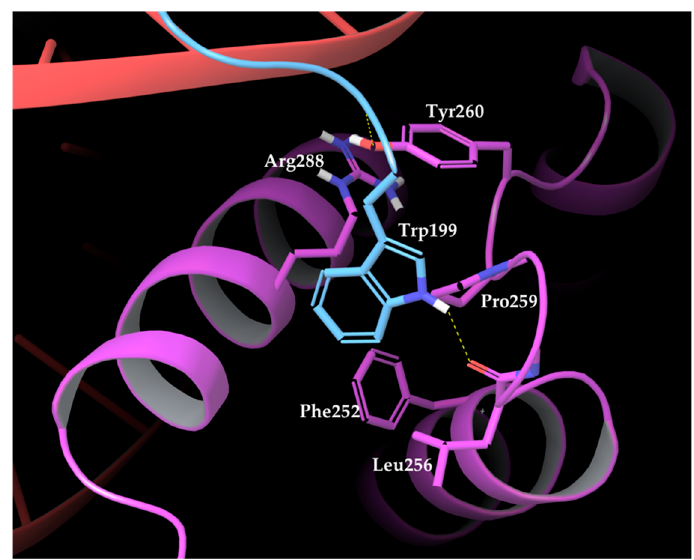
Figure 2. Amino acids composing PBX1 binding pocket (purple residues and chain) surrounding HOXA9 Trp199 (light blue chain) [27].